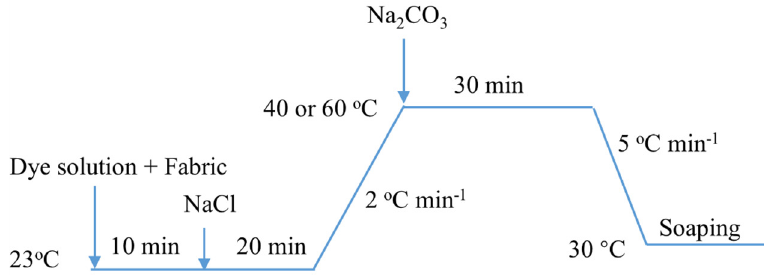
Figure 1. Dyeing of cotton fabric with R2 or R195.